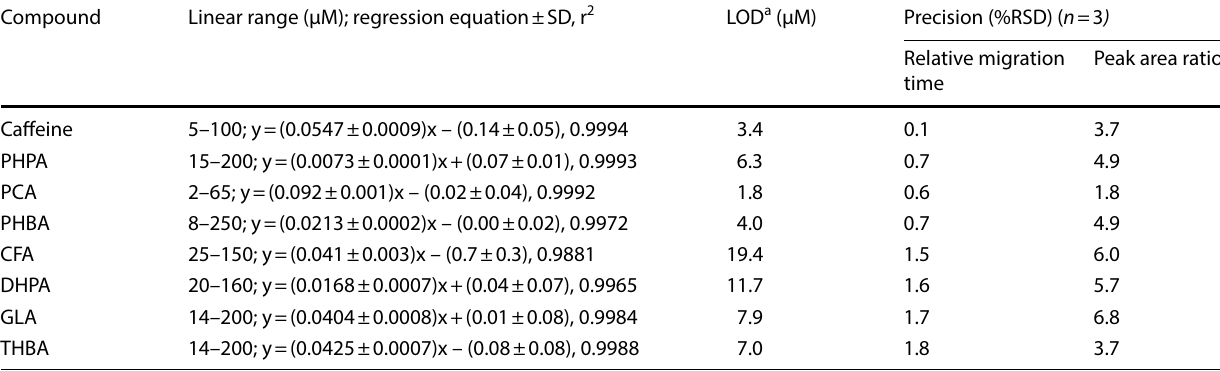
a LOD calculated from 3 × (SD of regression)/(slope of